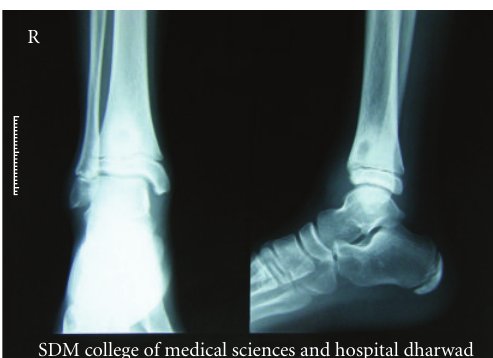
Figure 1: X-ray of right ankle joint showing submetaphyseal oste- olytic lesion with sclerotic margin, seen in distal end of right tibia.